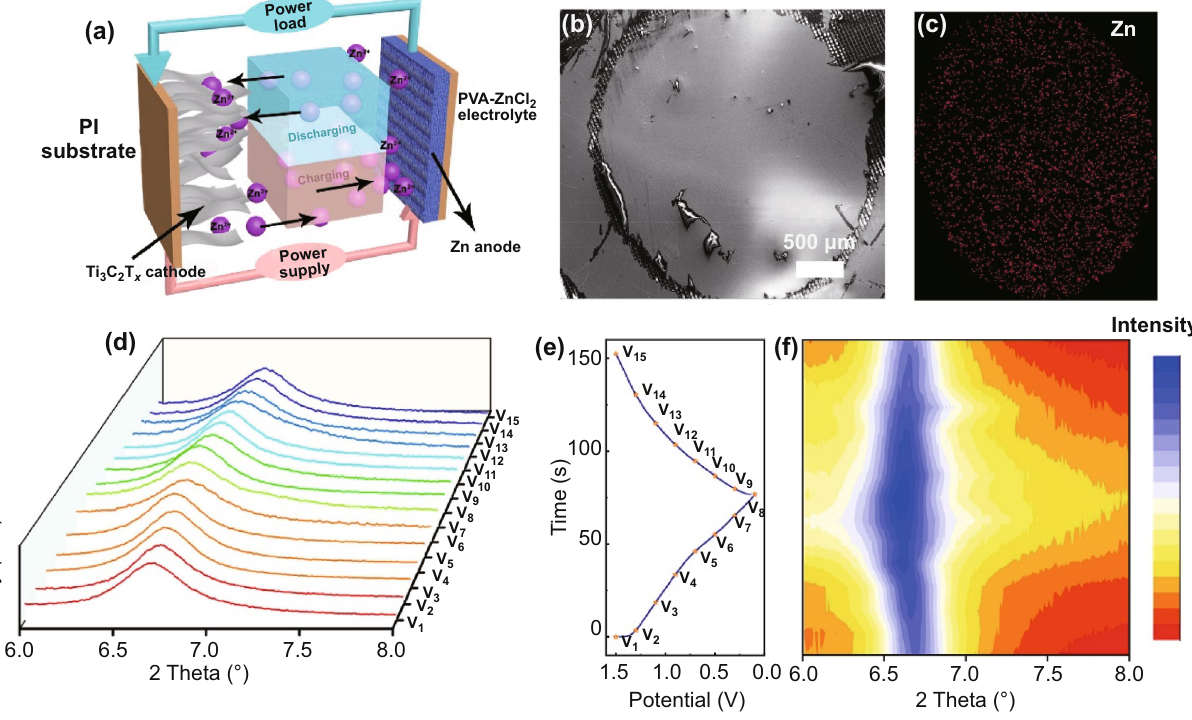
Fig. 4 Mechanism study of the Ti 3 C 2 T x -based concentric circular Zn-ion MSC. a Schematic illustration of the Ti 3 C 2 T x -based Zn-ion MSC dur- ing the discharging/charging process. b SEM image of the Ti 3 C 2 T x cathode after charging. c The corresponding Zn element dispersion in the Ti 3 C 2 T x cathode. d–f Ex-situ XRD patterns of the Ti 3 C 2 T x